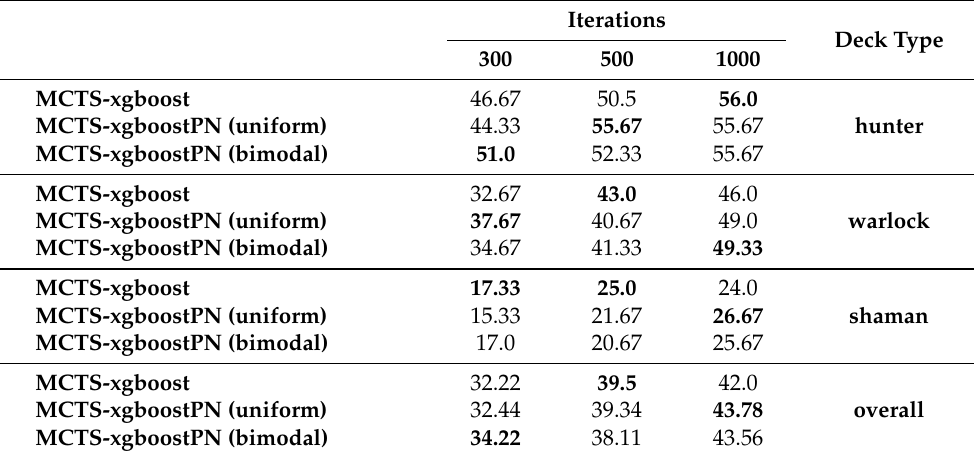
Table 3. Win rate per number of iterations against GSV (the highest win rate per deck type and number of iterations is indicated in